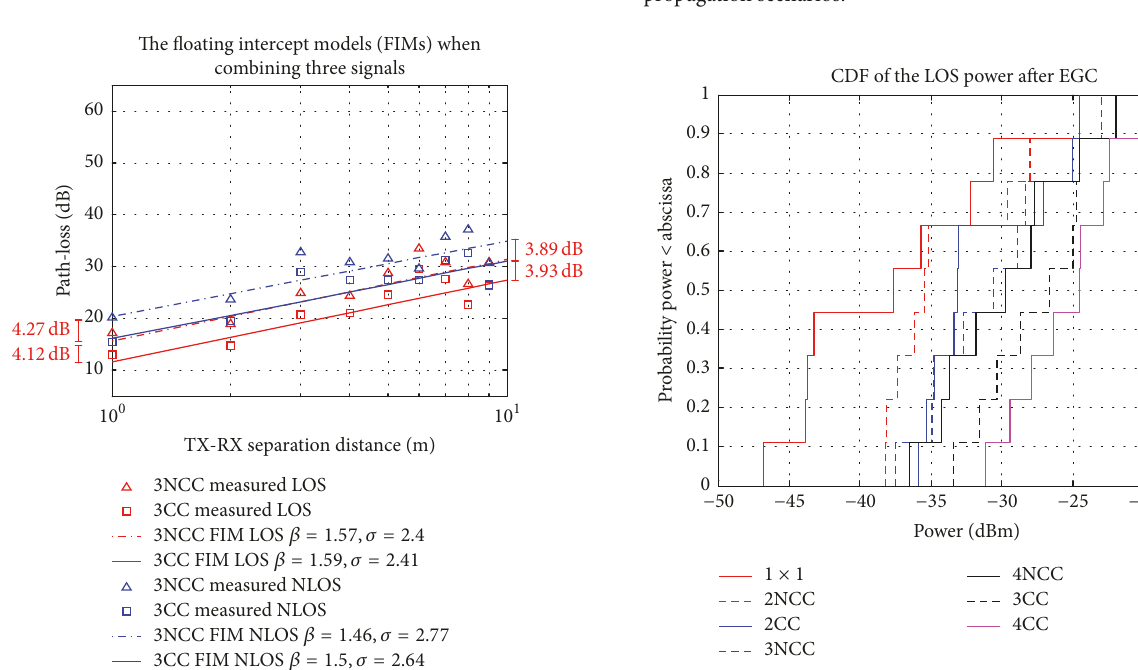
Figure 6: FIMs along with the scattered data for 1 × 2 SIMO case when considering CC and NCC for both the LOS and NLOS propagation scenarios.